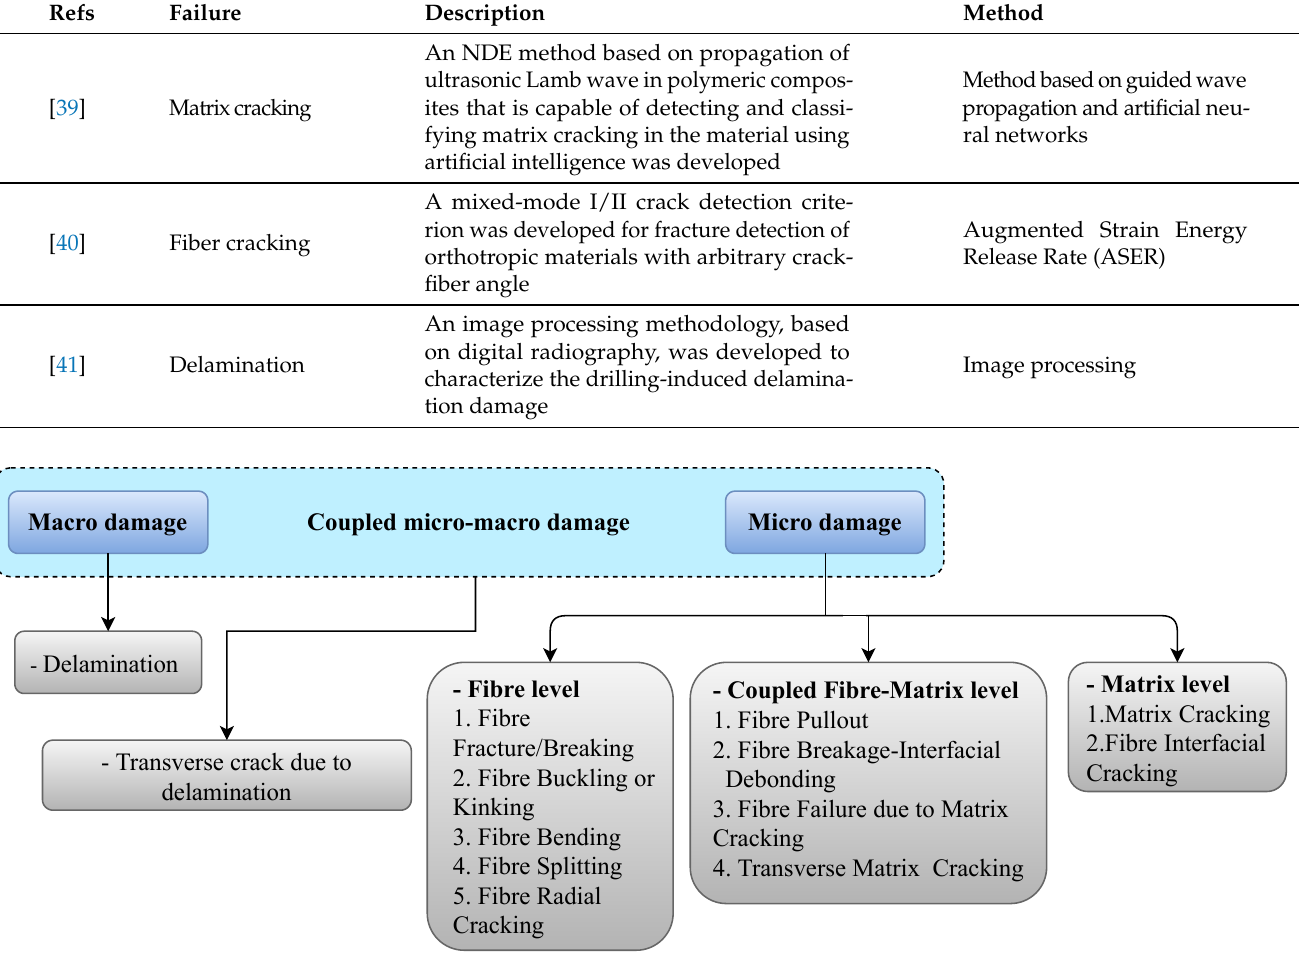
Figure 3. Types of damage in composite